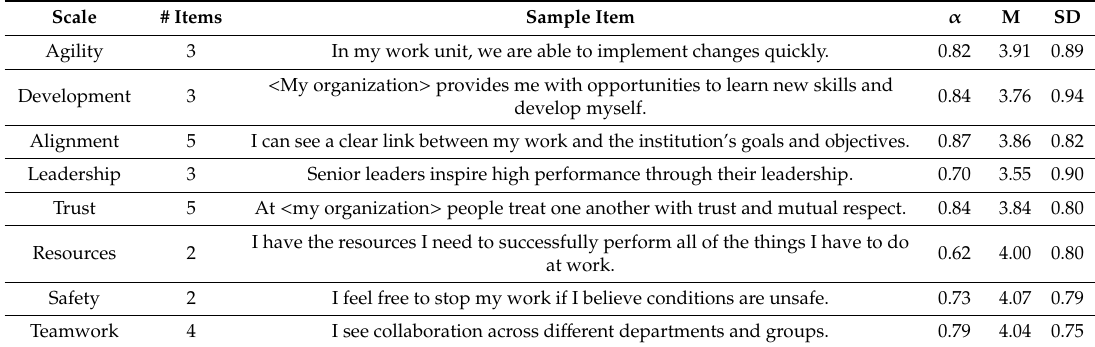
Table A1. Employee Job Attitudes